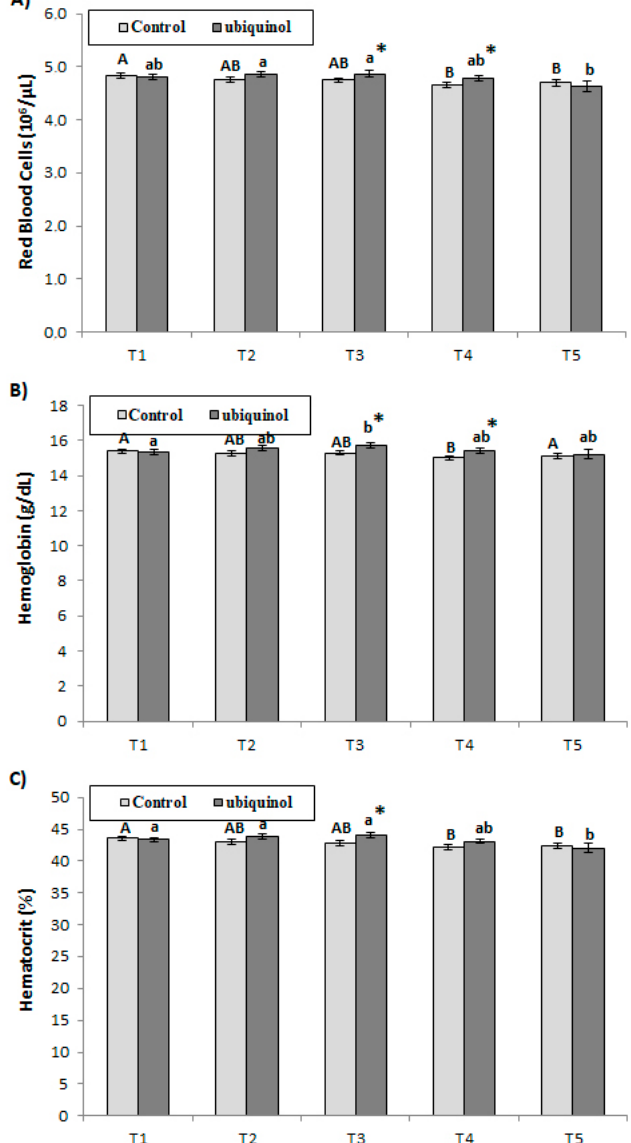
Figure 3. Effects of exercise and ubiquinol supplementation on hematological parameters: Red blood cells ( A ), hemoglobin ( B ), hematocrit ( C ). Results are expressed as mean ± SEM. * means statistically significant differences between groups ( p < 0.05). T1: Before supplementation (basal value); T2: After supplementation (two weeks) and before the first physical test; T3: After first physical exercise test; T4: After 24 h of rest and before the second physical test; T5: After second physical exercise test. Different letters in every group indicates significant differences due to the time (control (A, B, C, D, E); ubiquinol (a, b, c, d, e)) ( p < 0.05).